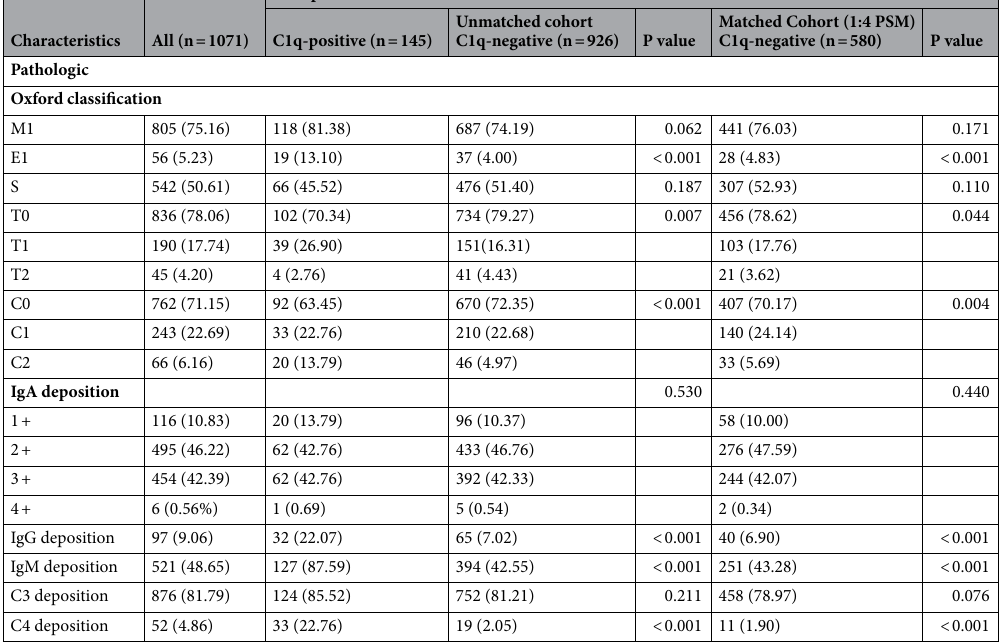
Table 2. Pathologic features of IgAN patients. Values for categorical variables are given as number (percentage); values for continuous variables are given as mean ± standard deviation or median (interquartile